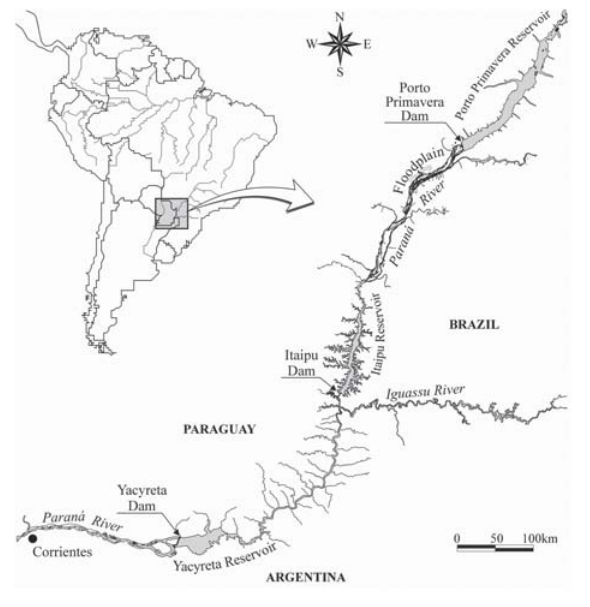
Fig. 1. Location of the Engenheiro Sergio Motta (Porto Primavera) Hydroelectric power plant in the Paraná River,